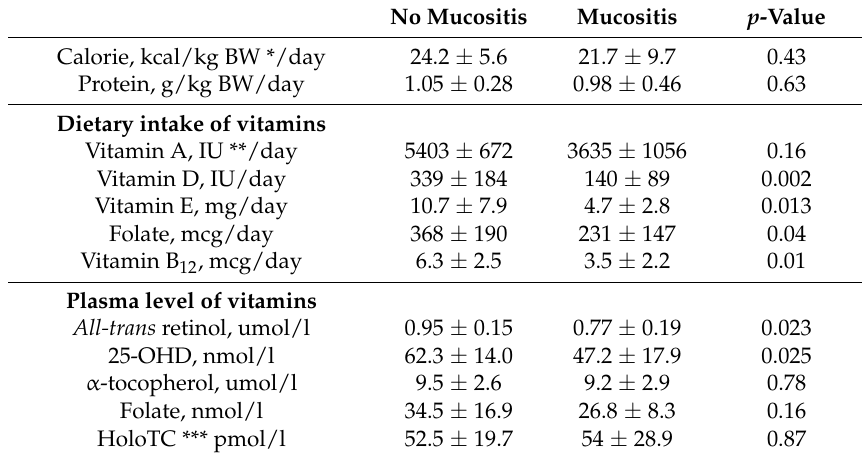
Table 5. Baseline dietary intake and plasma level of vitamins in patients based on mucositis